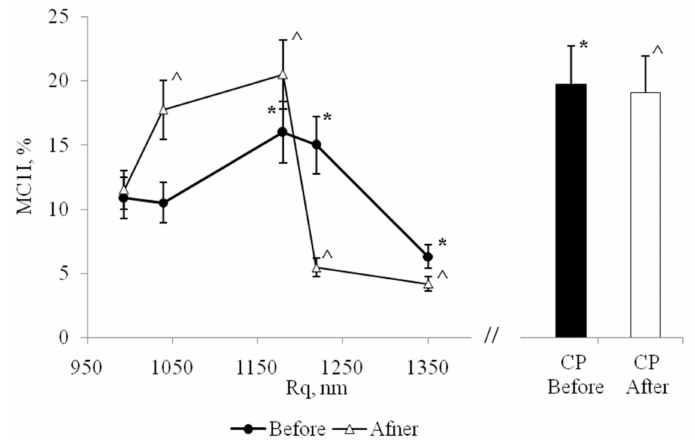
Figure 9. The dependence of the number of multinucleated MPhs (MC1I) on the value of Rq before (Before) and after (After) stenting. CP—cultural plastic. *—significant di ff erence from the value for the first point, Rq min = 993 nm, option before stenting, ( p < 0.05).ˆ—significant di ff erence from the value for the first point, Rq min = 993 nm, option after stenting, ( p <